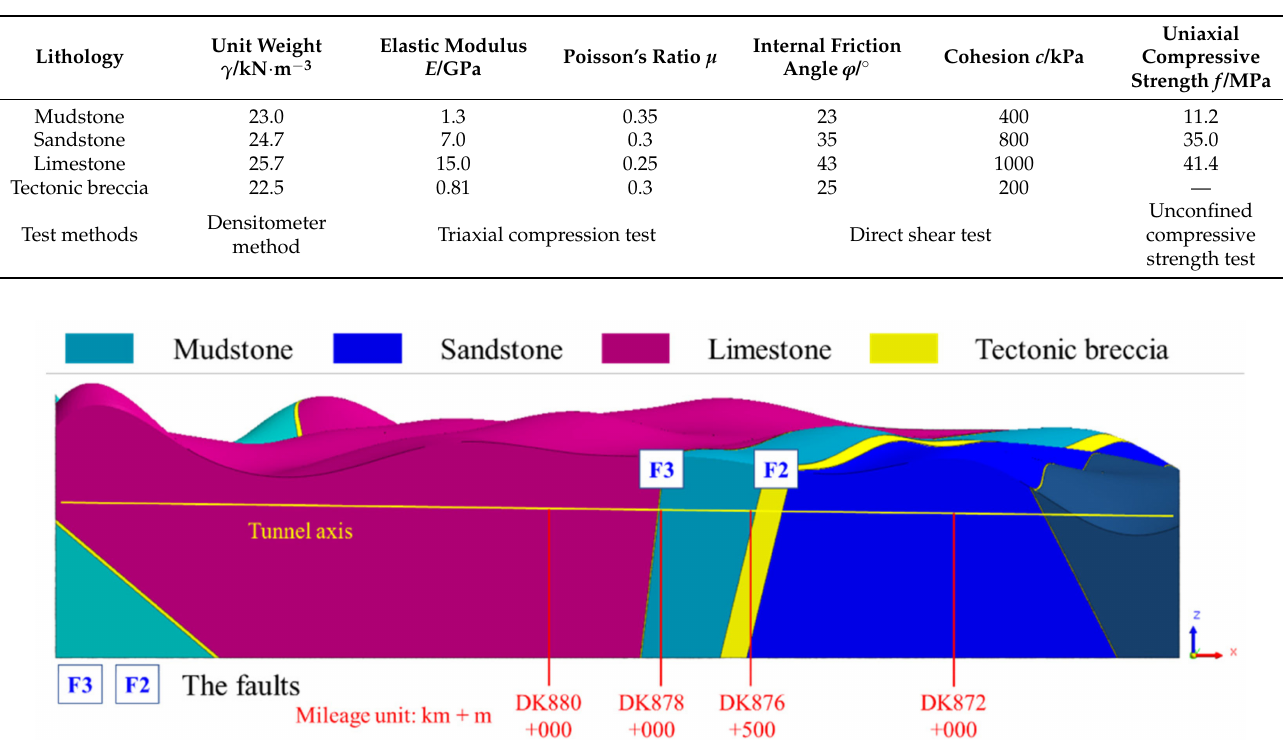
Table 4. Stratigraphic lithology and physical and mechanical parameters.